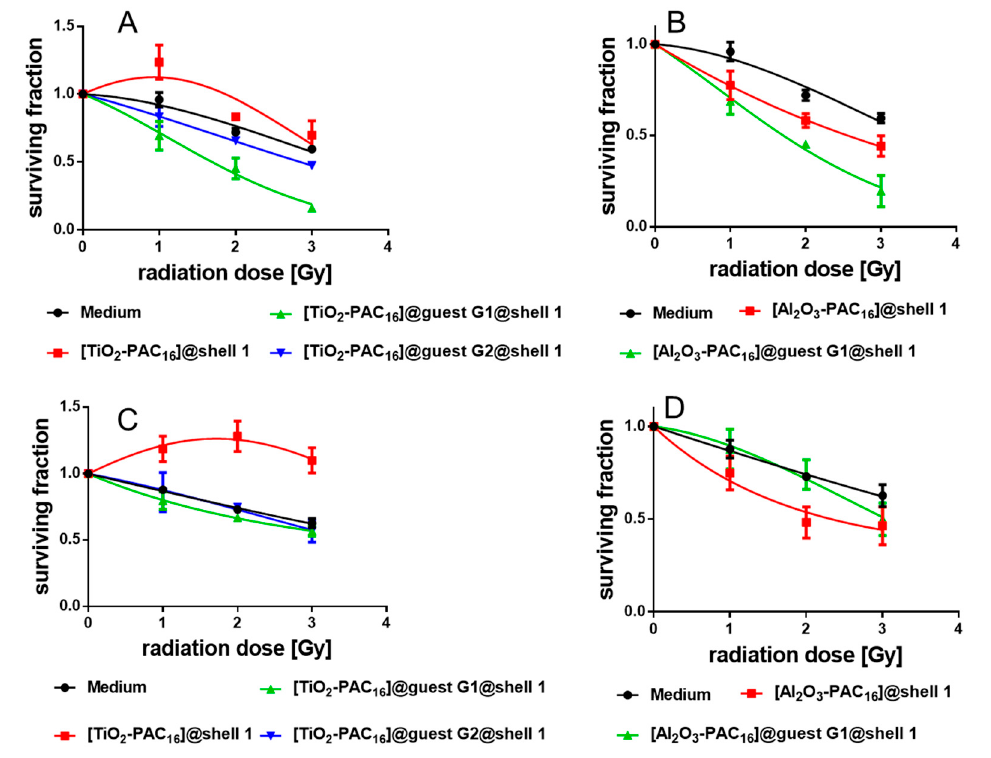
Figure 9. Cell survival curves of MCF-7 cells treated with unloaded and loaded TiO 2 nanocarriers ( A ) and Al 2 O 3 nanocarriers ( B ) and survival curves of the MCF-10 A cells treated with unloaded and loaded TiO 2 nanocarriers ( C ) and Al 2 O 3 nanocarriers ( D ).